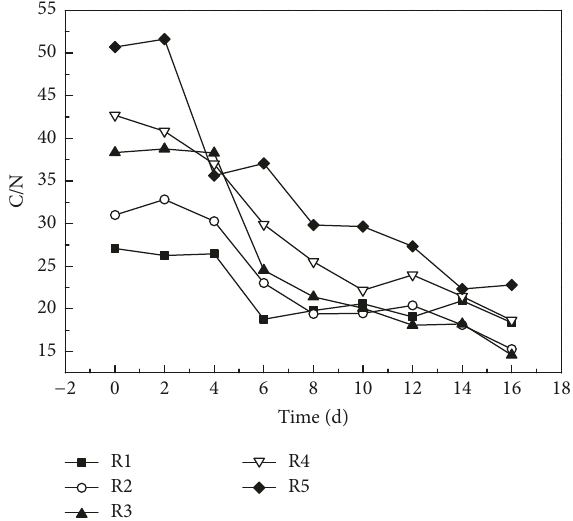
Figure 2: C/N for the composting of